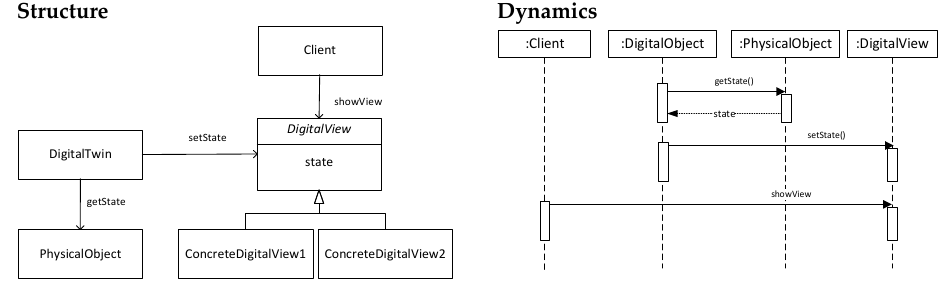
Figure 13. Digital Monitor pattern.